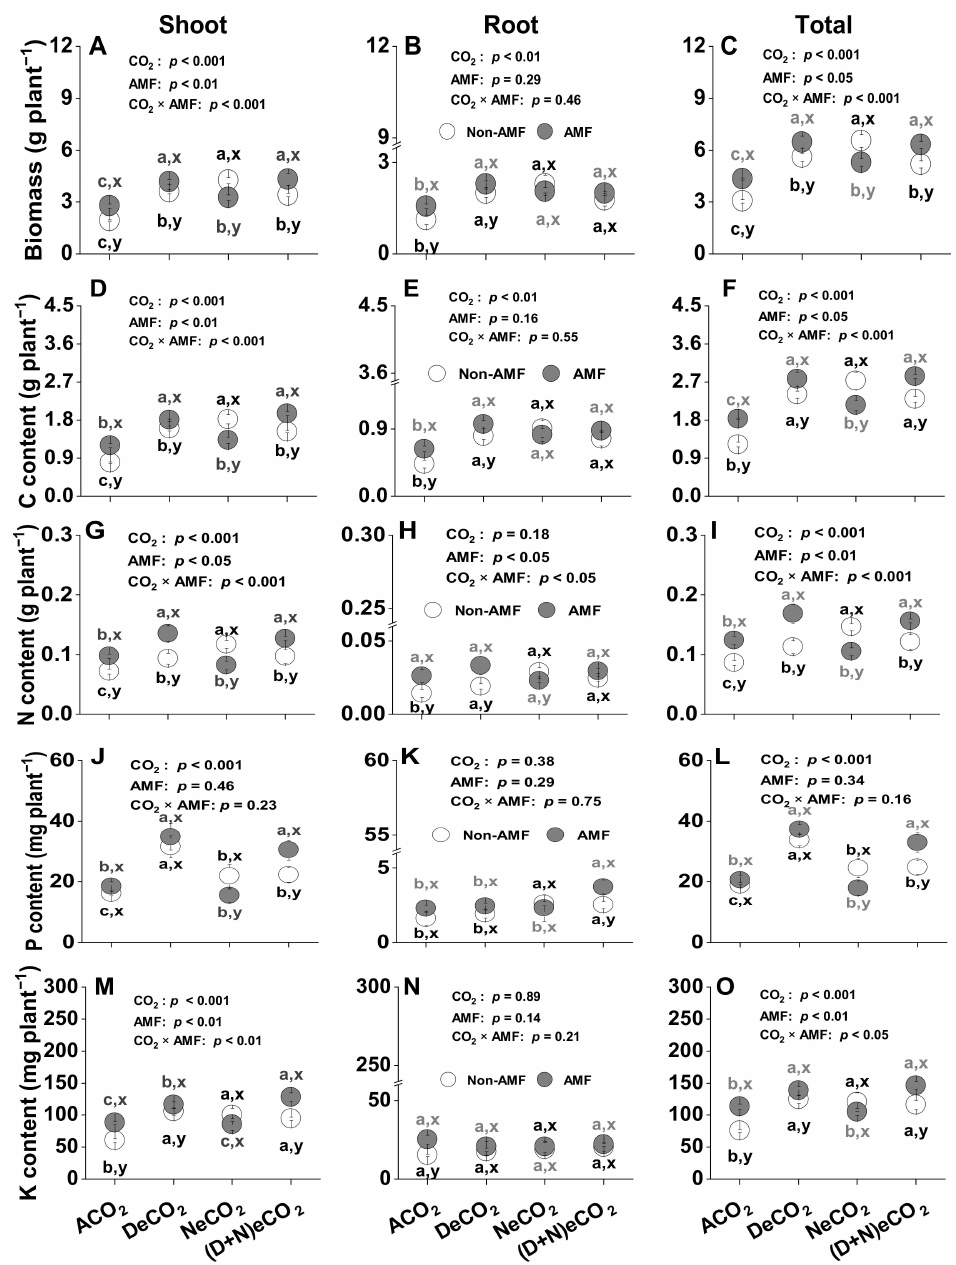
Figure 3. Effects of CO 2 and mycorrhiza on ( A ) shoot, ( B ) root, and ( C ) total plant biomass production; ( D ) shoot C, ( E ) root C, and ( F ) total plant C accumulation; ( G ) shoot N, ( H ) root N, and ( I ) total plant N accumulation; ( J ) shoot P, ( K ) root P, ( L ) total plant P accumulation; and ( M ) shoot K, ( N ) root K, ( O ) total plant K accumulation in 12-week-old wheat grown under different daytime and/or nighttime CO 2 concentrations inside environmentally controlled glass growth chambers. Values are the means ± standard error (SE), n = 3. Different letters above the bars indicate significant differences ( p < 0.05), as revealed by Tukey’s test. Statistical comparisons (two-way ANOVA) between eCO 2 or AMF treatments, as well as their eCO 2 × AMF interaction are presented for each variable. Abbreviations: ACO 2 , ambient CO 2 (410 ppm daytime + 460 ppm nighttime); DeCO 2 , elevated CO 2 at daytime (550 ppm daytime + 460 ppm nighttime); NeCO 2 , elevated CO 2 at nighttime (410 ppm daytime + 610 ppm nighttime); (D + N)eCO 2 , elevated CO 2 at both daytime and nighttime (550 ppm daytime + 610 ppm nighttime). Daytime: 07:00 a.m.–19:00 p.m. and nighttime: 19:00 p.m.–07:00